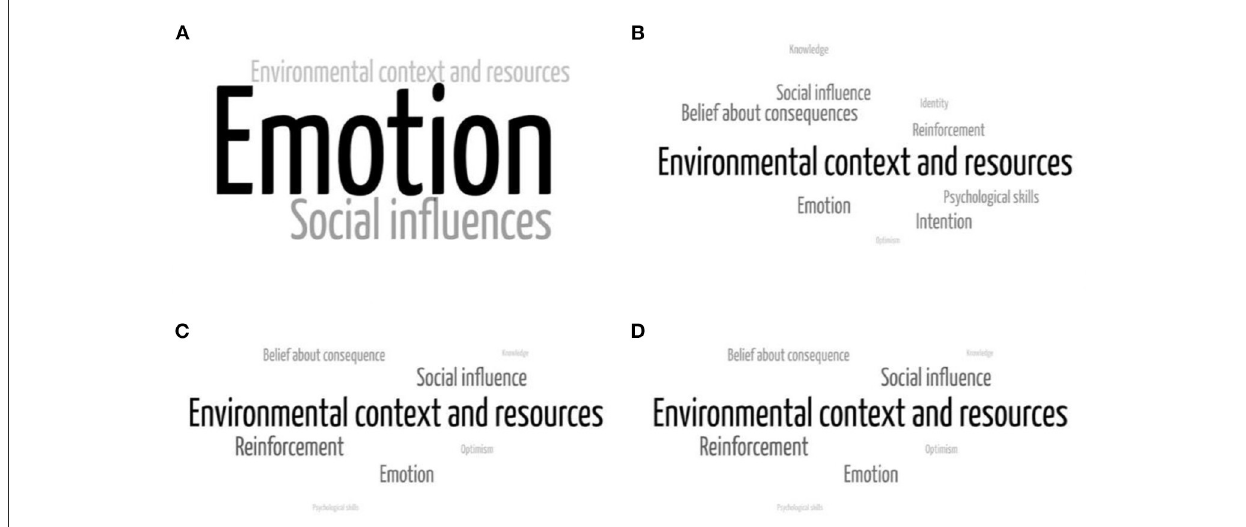
FIGURE1 Factors influencing intercity mobility restriction: (A) barriers among compliers, (B) facilitators among compliers, (C) barriers among non-compliers, and (D) facilitators among